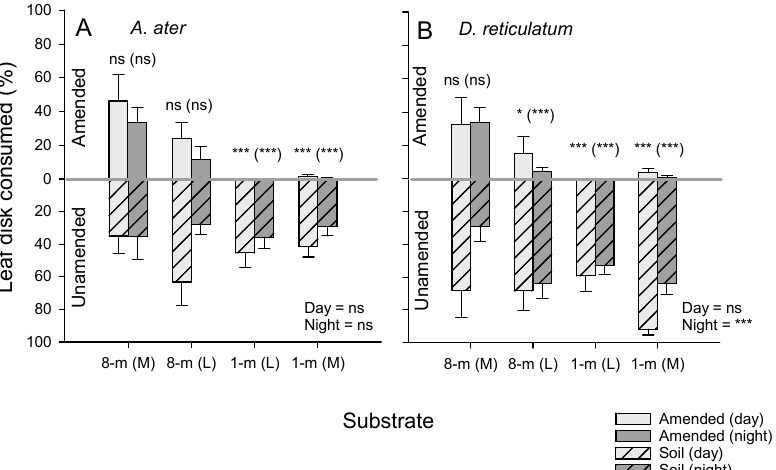
Figure 6. Results from binary-choice bioassays with A. ater ( A ) and D. reticulatum ( B ). Bioassays were conducted during daytime (light bars) and at nighttime (dark bars). Leaf disks (lettuce) were placed on amended and unamended soil in divided containers. The substrates included 8-month-old SCG mixed (M) with soil or as a top layer (L) and 1-month-old SCG mixed with soil or as a top layer. The percentages of leaf disks consumed over amended substrate (open bars) and unamended soil (hatched bars) are indicated. Results from GLMs based on differences between areas consumed in paired tests are presented for daytime (day) and nighttime (night) bioassays as ns = p > 0.05 and *** = p < 0.001 (N = 5). The results from paired t-tests for soil-amendment combinations are presented above the bars for daytime and nighttime (in parentheses) bioassays as ns = p > 0.05, * = p < 0.05 and *** = p < 0.001 (N = 5). Standard errors are indicated. (See also Tables S2 and S3).